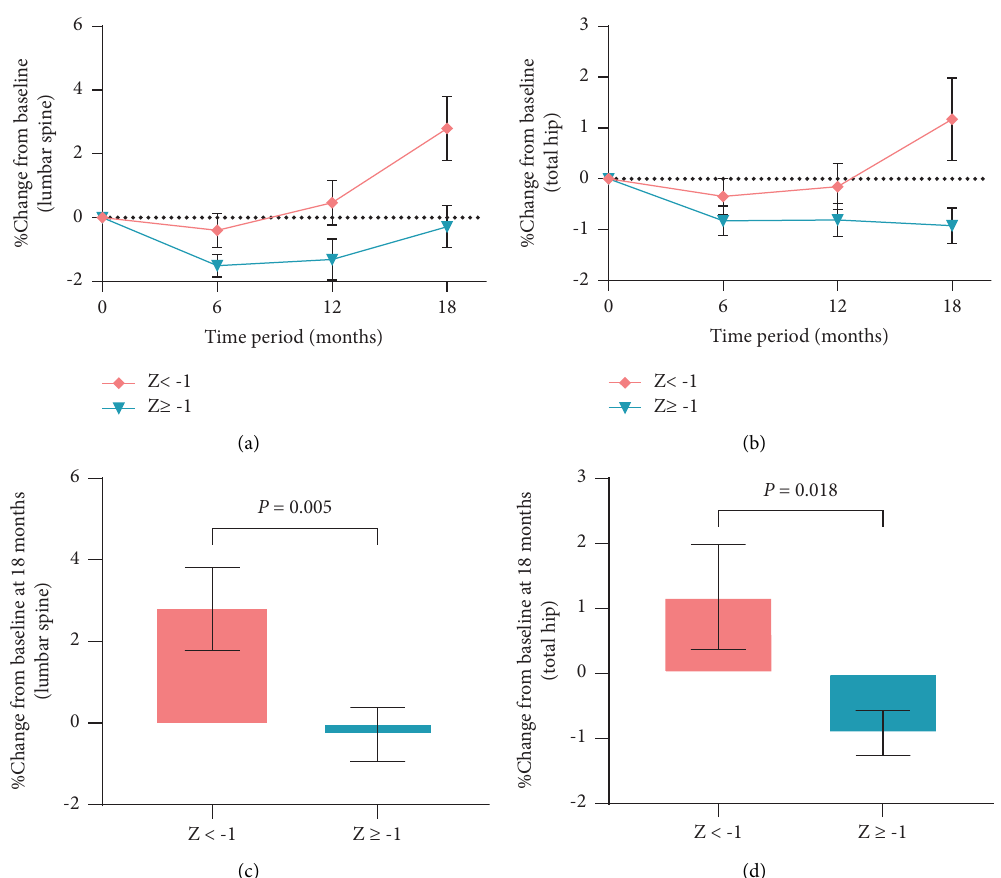
Figure 4: Diferences between diferent Z -scores’ groups in percentage change in BMD. (a) Changes in lumbar spine BMD over an 18- month treatment period; (b) changes in total hip BMD over an 18-month treatment period; (c) diference in change between diferent Z - scores’ groups in lumbar spine BMD at the 18 th month. P < 0 . 01 for the Z < − 1 group compared with the Z ≥ − 1 group (Mann–Whitney U test); (d) diference in change between diferent Z -scores’ groups in total hip BMD at the 18 th month. P < 0 . 05 for the Z < − 1 group compared with the Z ≥ − 1 group (Mann–Whitney U test). Te results are presented as the mean ± SE.